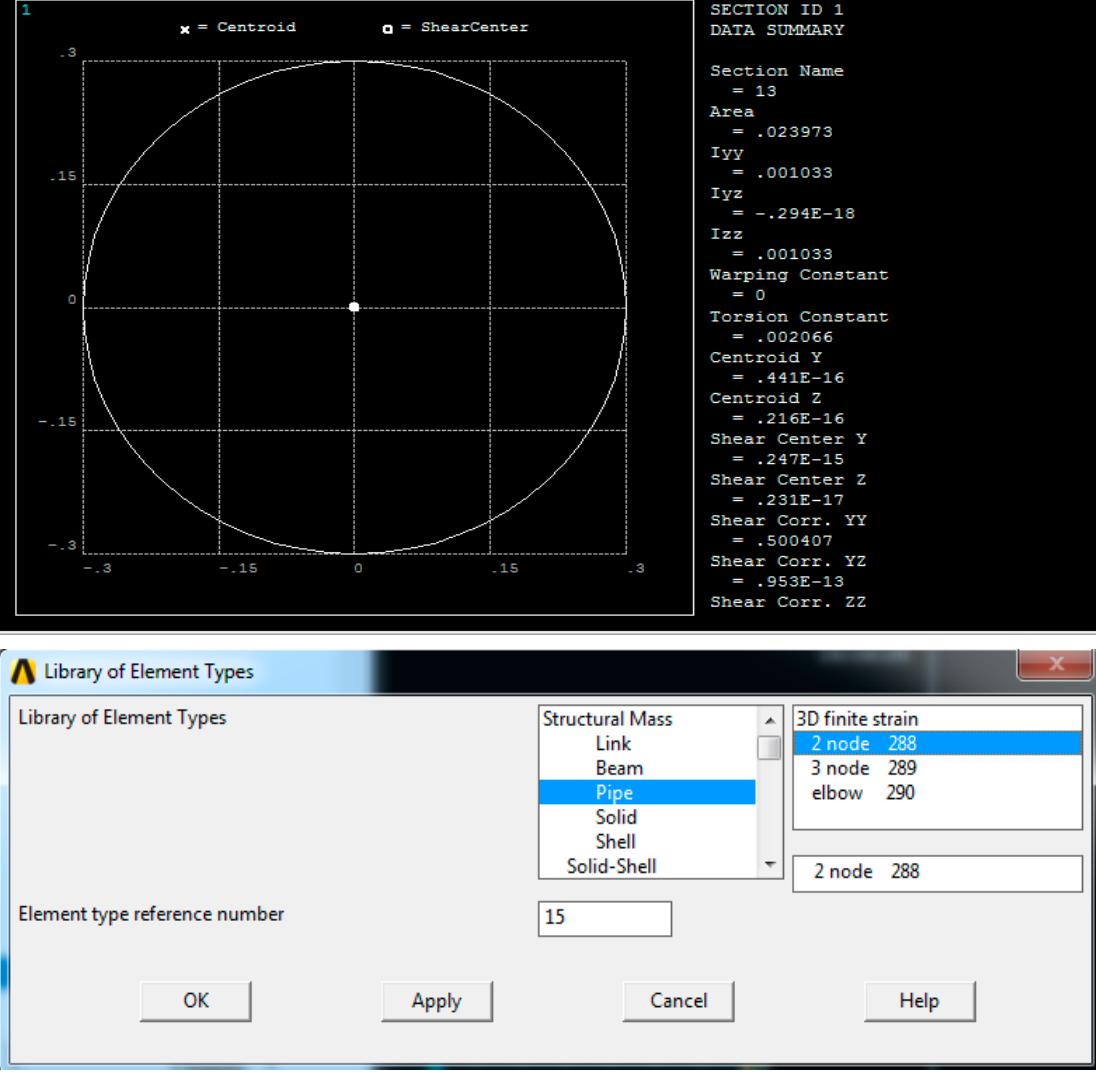
Figure 8. Element type and geometry details of the GPC pipe model.